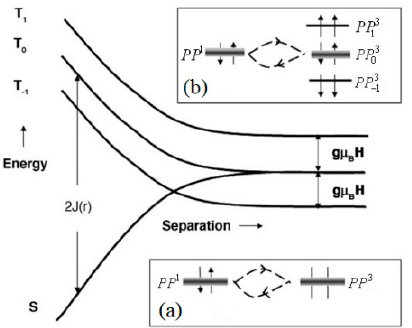
Figure 13. Structure change of single and triplet energy levels with different distances. The insets are schematic diagrams of the mutual transformation between singlet and triplet polaron pairs when ( a ) B = 0 and ( b ) B ≠ 0. By Prigodin et al. [61] with the permission of Synthetic Metals .